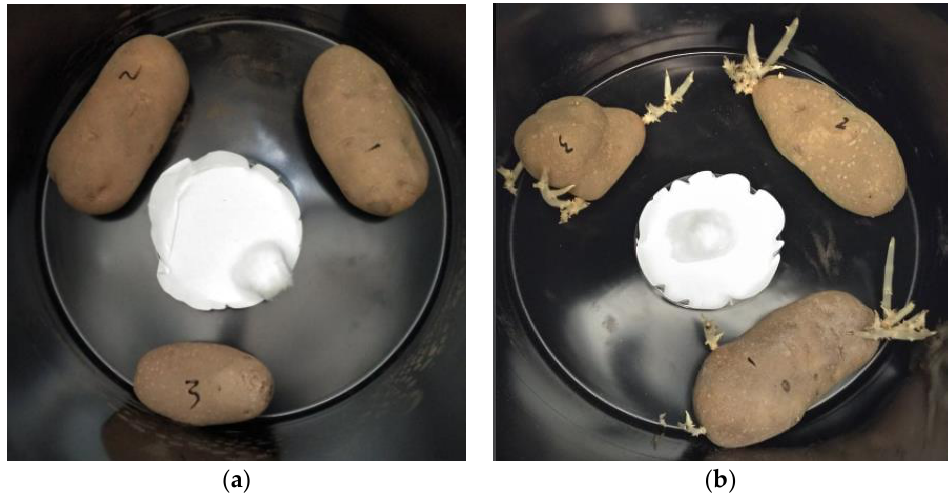
Figure 3. Ranger Russet tubers treated with ( a ) Cymbopogon citratus essential oil (EO) and ( b ) distilled water at 90 days of storage.